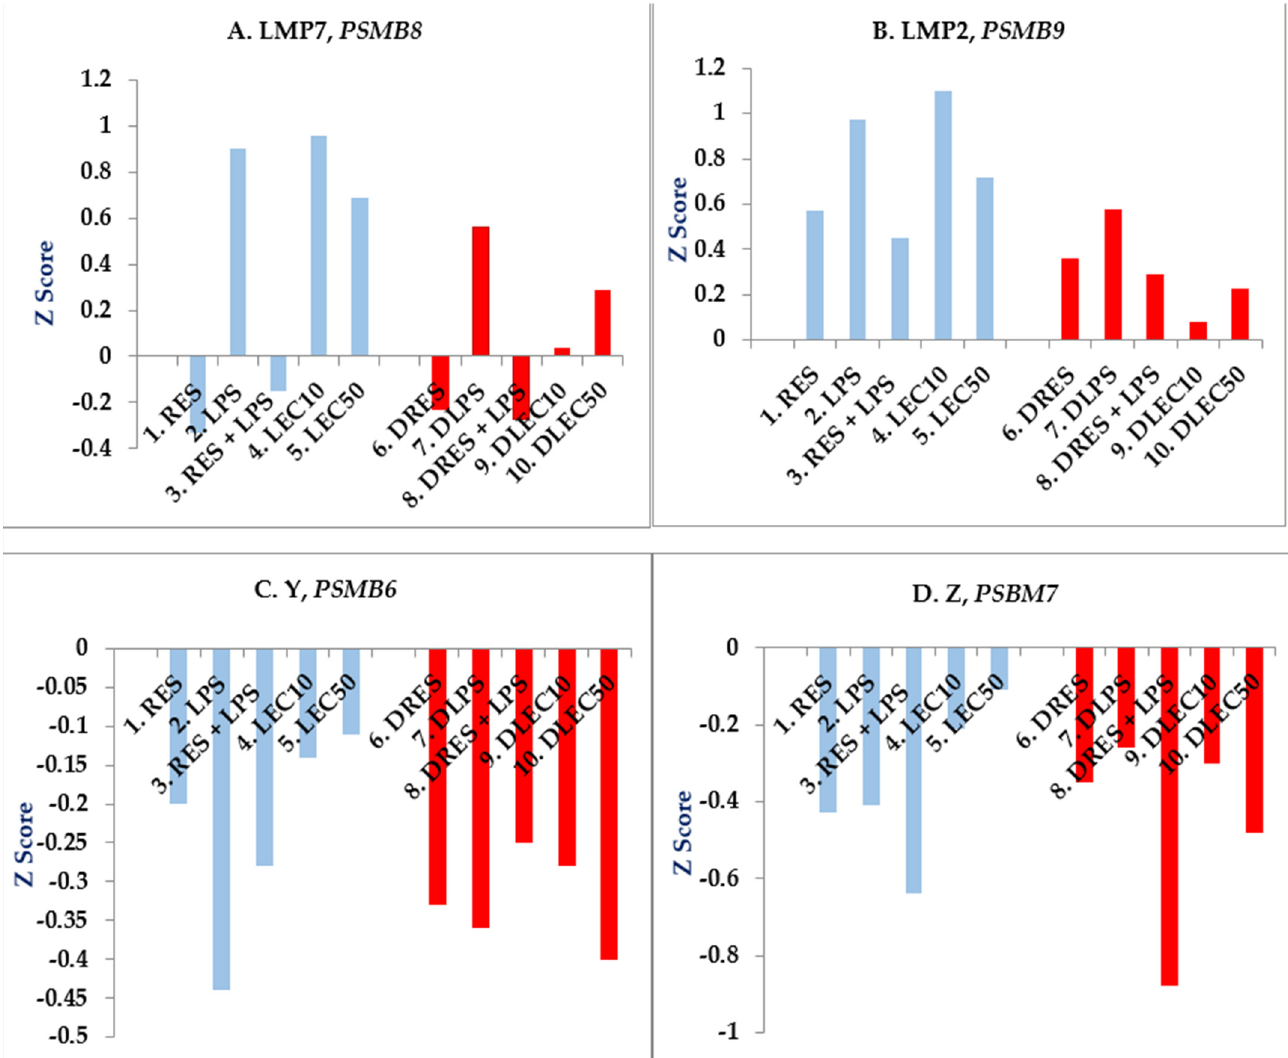
Figure 4. ( A – D ) Modulation of proteasome subunits: the effect of LPS, LEC10, LEC50, and RES on gene expression of proteasome’s subunits X, Y, Z, LMP7, LMP2, and LMP10 was determined in PBMCs from PwD2 and non-diabetic controls. Gene expression of subunits X and LMP10 was not induced in human PBMCs from non-diabetic controls and PwD2. Human PBMCs were treated with compounds and vehicle for 3h. RNA was extracted from the cells and analyzed using NGS. These data were extracted using the DEG analysis. Z score values were plotted against the proteasome subunits. Control PBMCs (C), RES (R); LPS (L); LPS + RES (L + R); LEC10; LEC50; and Diabetic PBMCs: RES (DR); LPS (DL); LPS + RES (DL + R); LEC10 (DLEC10); and LEC50 (DLEC50). Blue bars indicate values for gene expression of non-diabetic controls [54] and red bars indicate values for PwD2.